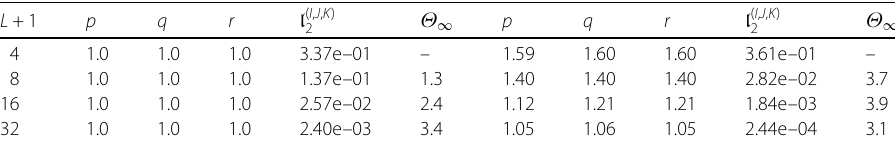
Table 2c Errors and order for UM-FOCS and EEG-TOCS in Example 5.2